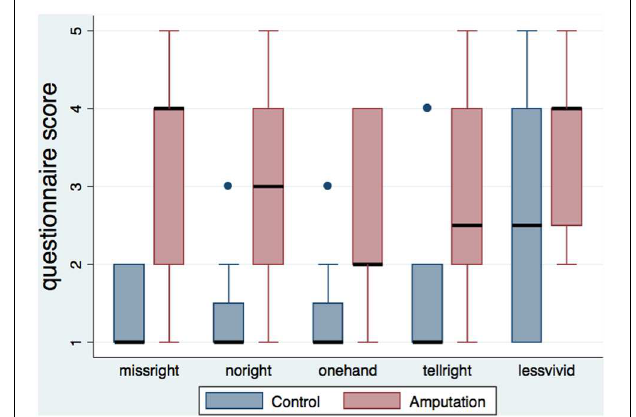
FIGURE 2 | Boxplot of the amputation related statements per condition. The height of the boxes represents the interquartile ranges, the black lines represent the medians and the blue dots represent the outliers. Participants in the amputation condition rated the statements related to the illusion of amputation significantly higher than the control